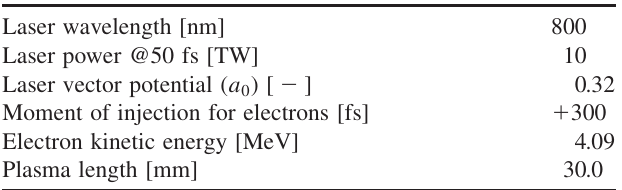
TABLE II. Initial parameters of electron bunches injected behind the laser